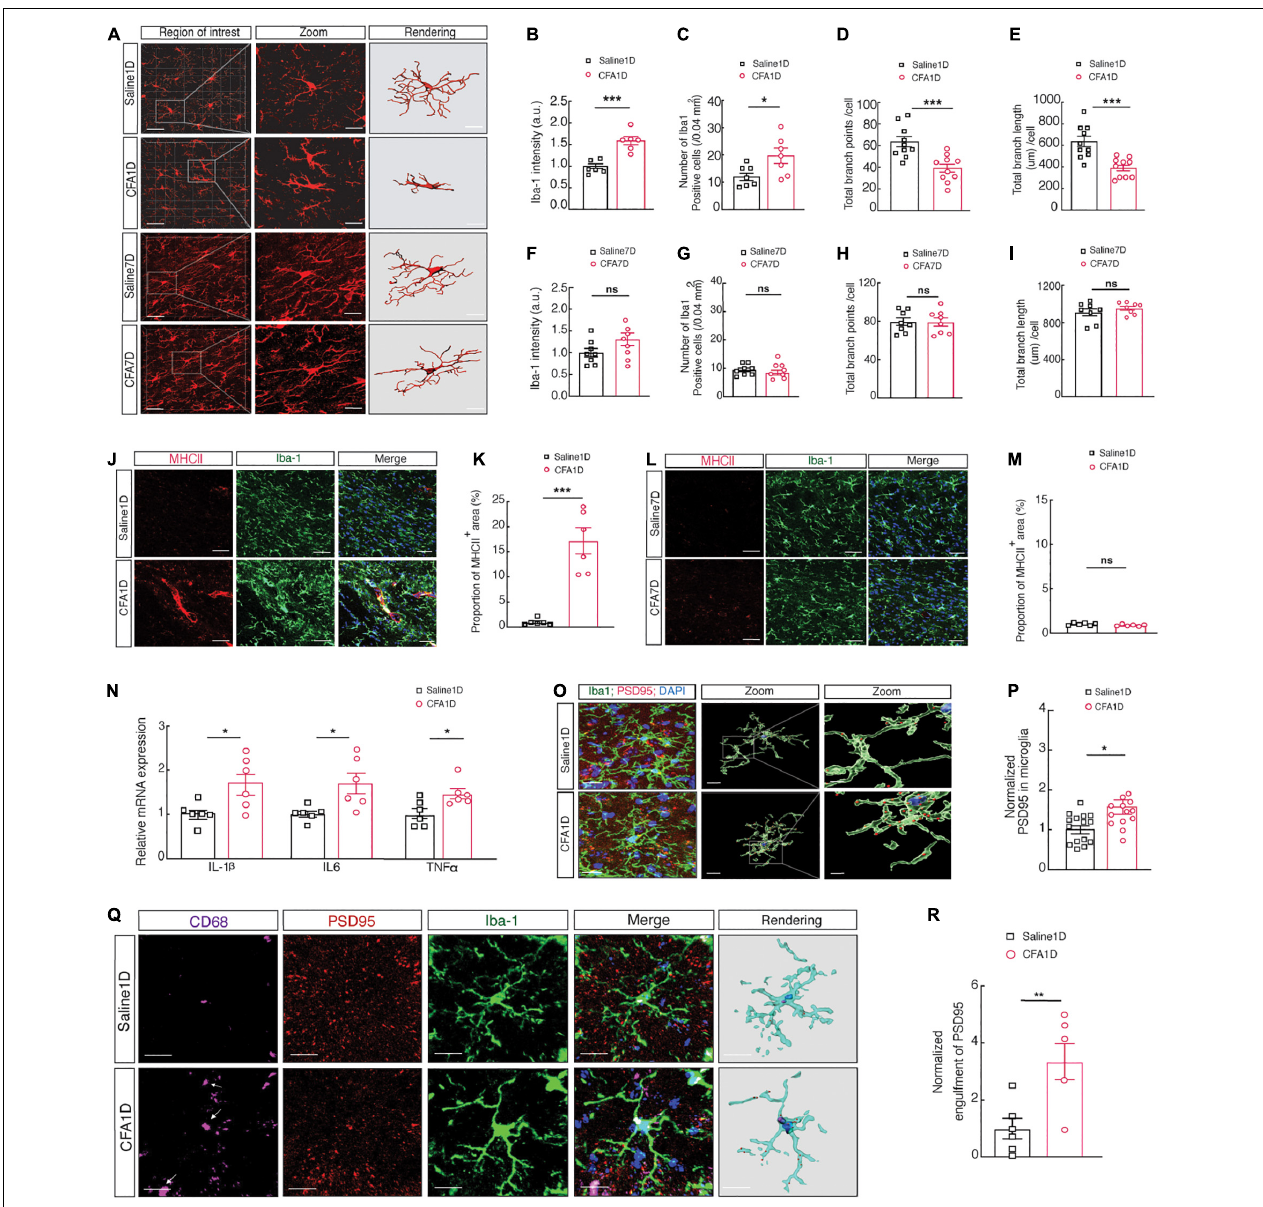
FIGURE 4 | Increased microglial cell activity and engulfment of ZI VGABA spines in CFA1D mice. (A) Fluorescence images displaying Iba-1 immunostaining (red) and 3D reconstruction of microglia in the ZI V of saline1D-, CFA1D-, saline7D- and CFA7D mice. The scale bars are 40 µ m (overview) and 10 µ m (inset and rendering). (B,C) Statistical data for the number of Iba-1 + cells per cubic millimeter ( t 10 = 2.46 and P = 0.029) and Iba-1 intensity ( t 10 = 5.42 and P = 0.003) in the ZI V from saline1D- and CFA1D mice. (D,E) Summary data of microglia branches endpoints ( t 18 = 4.07 and P = 0.0007) and total process lengths per cell of Iba-1 + microglia ( t 18 = 4.43 and P = 0.0003) in ZIv from saline1D and CFA1D mice. (F,G) Statistical data for the number of Iba-1 + cells per cubic millimeter ( t 14 = 0.9354 and P = 0.365) and Iba-1 intensity ( t 14 = 1.765 and P = 0.0994) in the ZI V from saline7D- and CFA7D mice. (H,I) Summary data of total microglia endpoints ( t 14 = 0.06 and P = 0.953), and total branches lengths per cell of Iba-1 + microglia ( t 14 = 0.965 and P = 0.3505) in ZIv from saline7D and CFA7D mice. (J,K) Representative images (left) and quantitative analyses (right) of immunostaining for Iba-1 (green) and MHCII (red) ( t 10 = 6.178 and P = 0.0001) in the ZI V of saline1D- or CFA1D-treated mice. Scale bar, 10 µ m. (L,M) Representative images (left) and quantitative analyses (right) of immunostaining for Iba-1 (green) and MHCII (red) ( t 10 = 1.799 and P = 0.1022) in the ZI V of saline7D- or CFA7D-treated mice. Scale bar, 10 µ m. (N) qPCR analysis of IL-1 β ( t 10 = 2.719 and P = 0.0216), IL6 ( t 10 = 2.901 and P = 0.0158), and TNF α ( t 10 = 2.740 and P = 0.0208) mRNA in ZI V tissues from saline1D and CFA1D mice. (O) Illustrative images and 3D reconstruction surface rendering of Iba-1 + microglia (green) including PSD95 + puncta (red) and DAPI (blue) in the ZI V from saline1D- and CFA1D- treated mice. Scale bars, 10 µ m (overview) and 2 µ m (inset and rendering). (P) PSD95 + puncta’s quantification of microglia in slices ( t 26 = 2.71 and P = 0.011, n = 14–16 slices per group from four mice) as showed in (O) . (Q,R) Representative images (left) and quantitative analyses (right) of immunostaining for Iba-1 (green), CD68 (purple), and PSD95 (red) ( t 10 = 3.212 and P = 0.0093) in the ZI V of saline1D- or CFA1D-treated mice. Scale bar, 10 µ m. All data are presented as mean ± SEM. n = 6–10 slices per group from three mice. Unpaired- t test. * P < 0.05; ** P < 0.01, and *** P < 0.001; ns, not